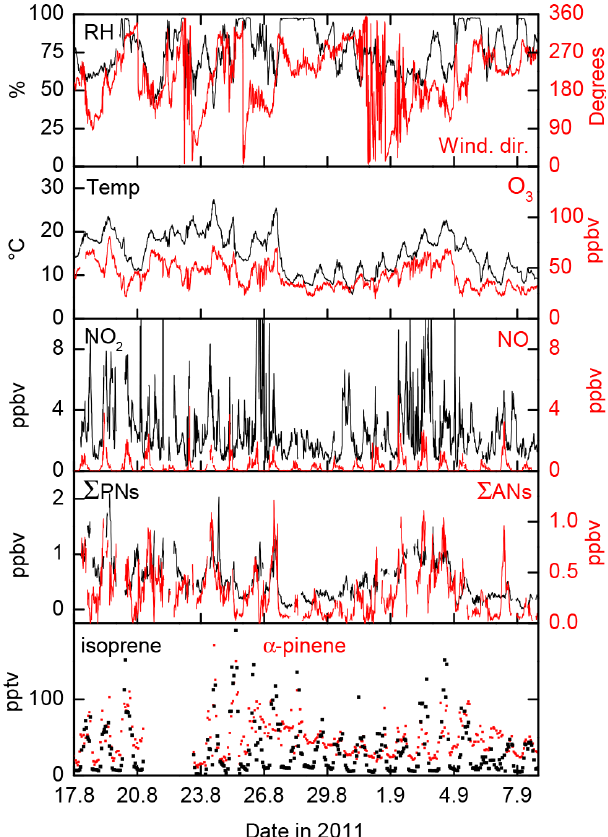
Figure 1. PARADE 2011: time series of relative humidity (RH), wind direction, temperature, and the O 3 , NO 2 , NO, (cid:54) PN, and (cid:54) AN mixing ratios. The lowest panel shows the mixing ratios of isoprene (black datapoints) and α -pinene (red